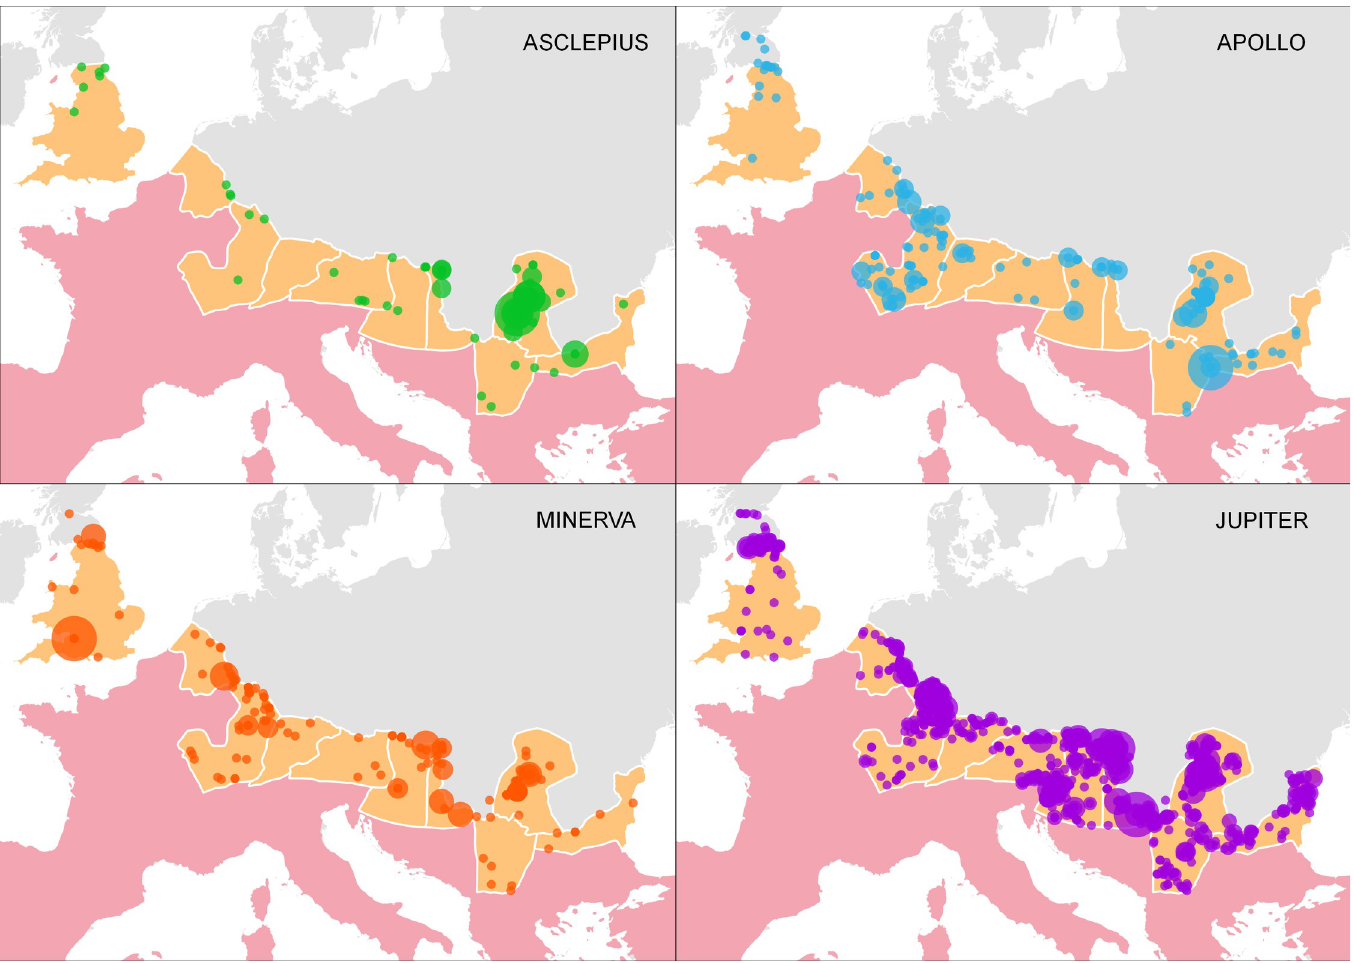
Fig 3. Inscriptions with Asclepius, Apollo, Minerva, and Jupiter from the period of the Roman Empire in the area of interest. The bigger the circle is, the more inscriptions share those coordinates. Sources: Natural Earth [31]; Ancient World Mapping Center (AWMC) [32]—Reprinted from AWMC database of shapefiles [32] under a CC BY license, with permission from AWMC, original copyright 2012; Epigraphic Database Heidelberg [29]; Dataset of the variables [49].